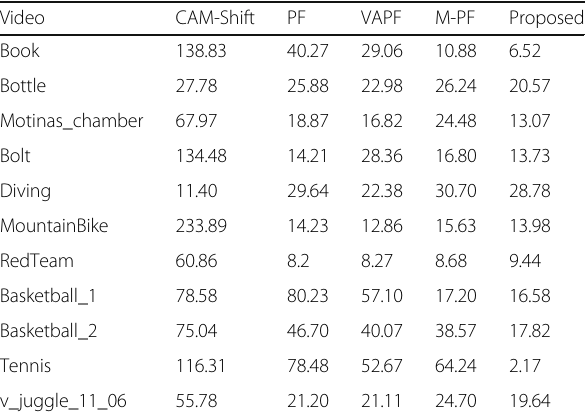
Table 5 Resulting of averaged Euclidian distance Video